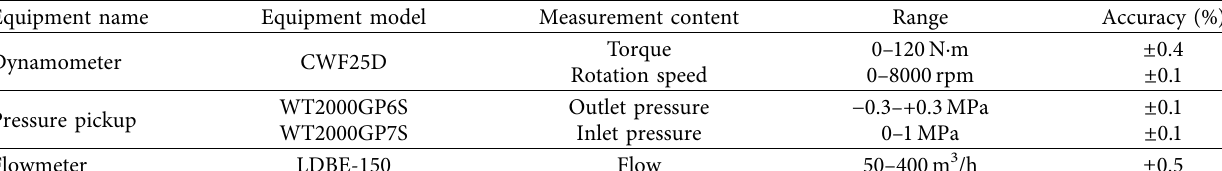
Table 4: Parameters of the measurement equipment.